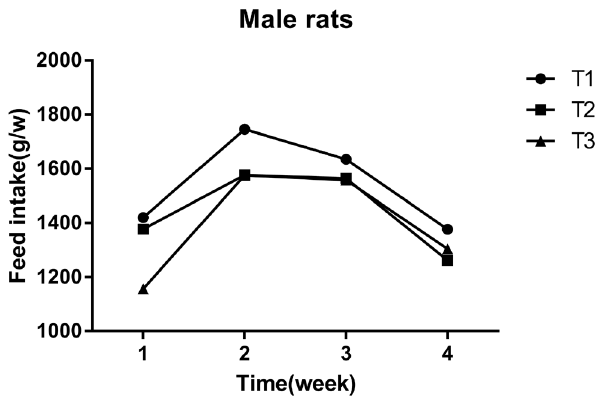
Figure 3. Effect of mulberry leaves on feed intake of Female rats. The x- and y-axes indicate time and feed intake, respectively. T1 = control group, T2 = low dose group, T3 = high dose group.